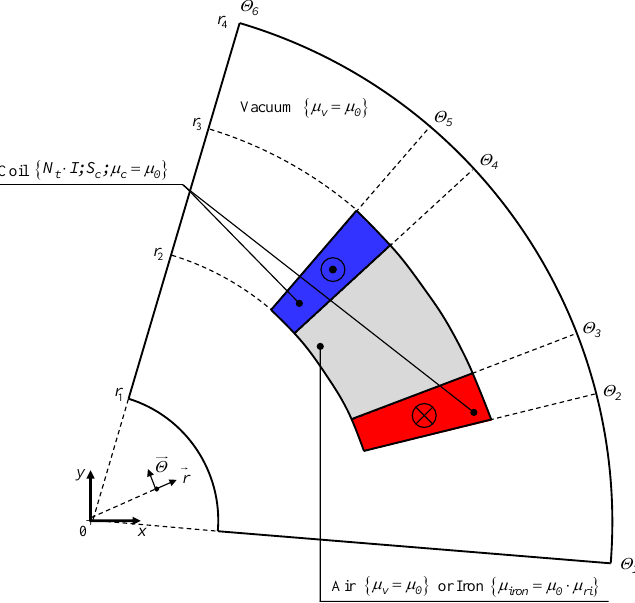
Figure 1. Physical and geometrical parameters (see Table 1) of air- or iron-cored coil where ⊗ and (cid:12) are respectively the forward and return conductor. The variables are: N t the number of turns; I the supply current; S c the conductor surface; u v the vacuum magnetic permeability; u c the copper magnetic permeability; and u iron the iron magnetic